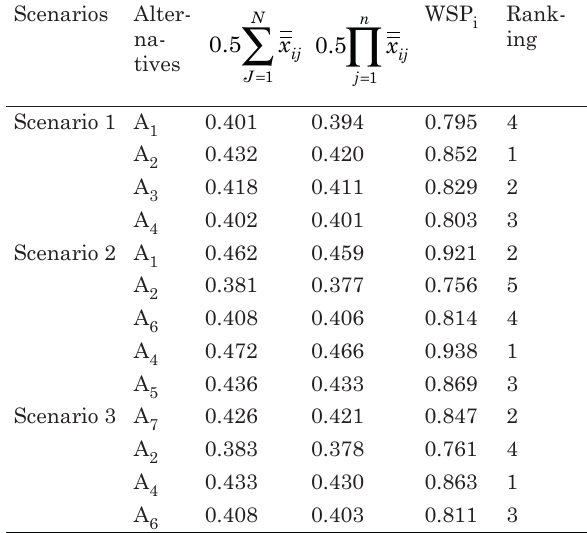
Table 13. results-based